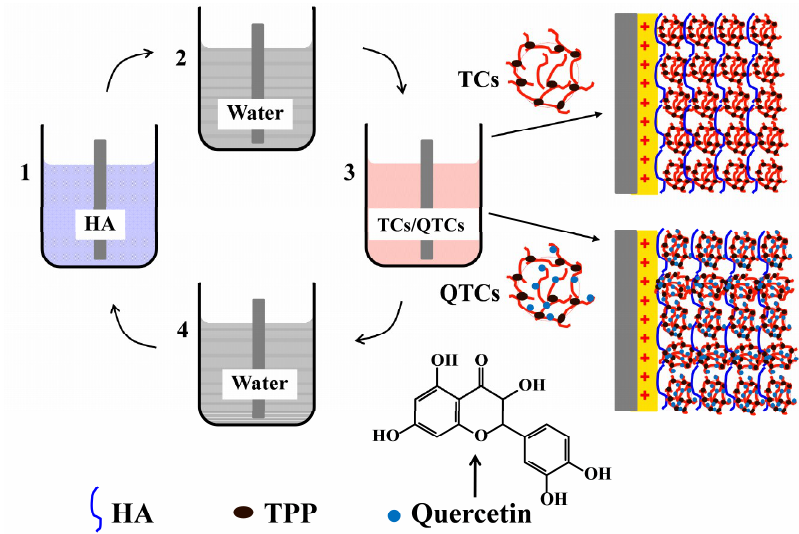
Figure 1. Schematic representation of the construction of hyaluronan acid (HA)/quercetin-loaded tripolyphosphate (TPP)–chitosan nanoparticle (QTCs) and HA/TPP–chitosan nanoparticle (TCs) multilayer thin films by layer-by-layer (LbL).